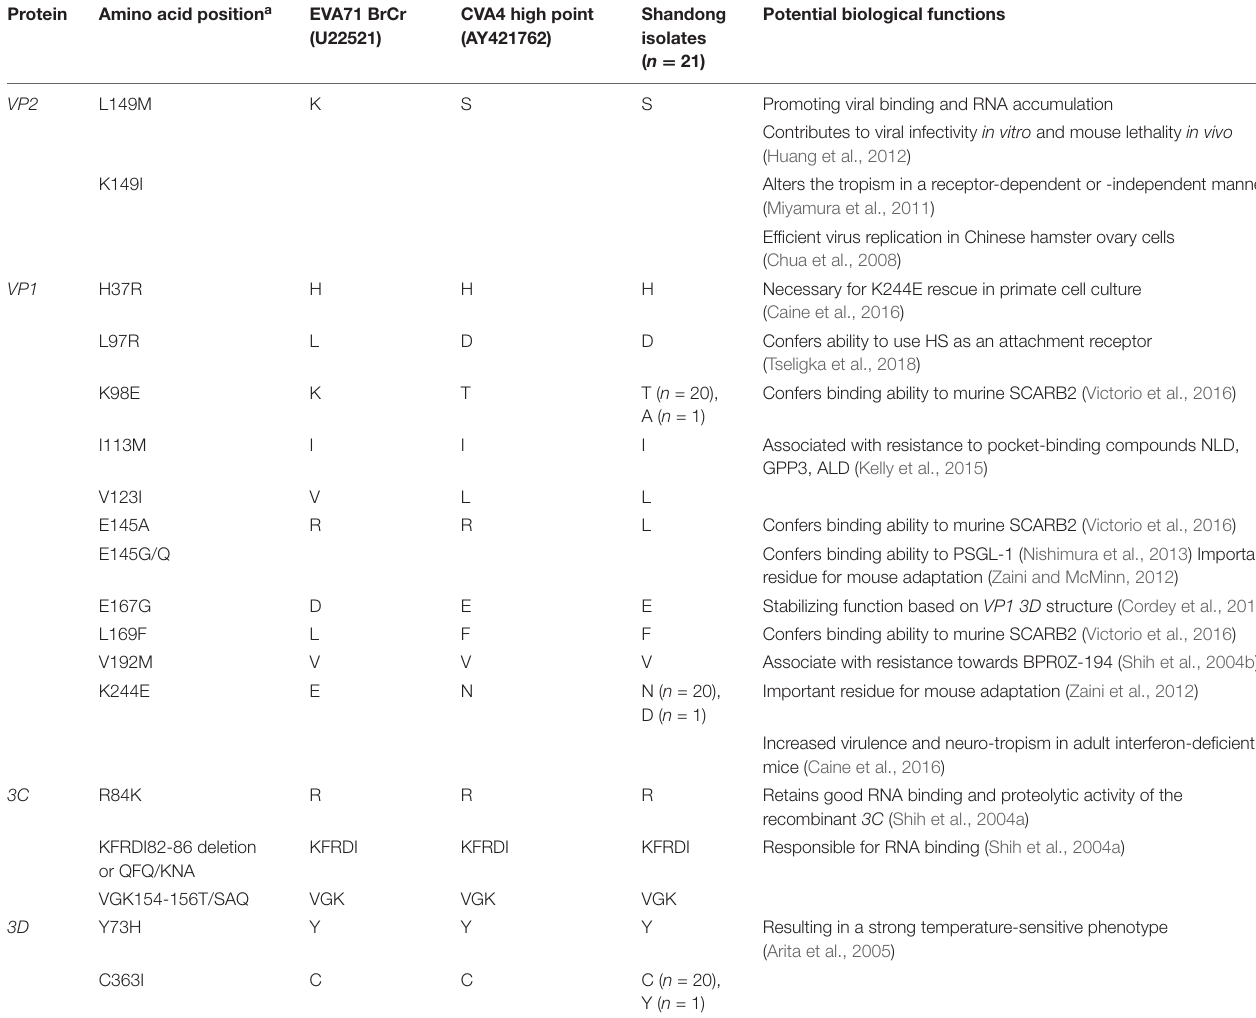
TABLE 1 | Comparison of potential critical amino acid residues of the prototype EV71 and CVA4 strains and the 21 isolates described in the present study. Protein Amino acid position